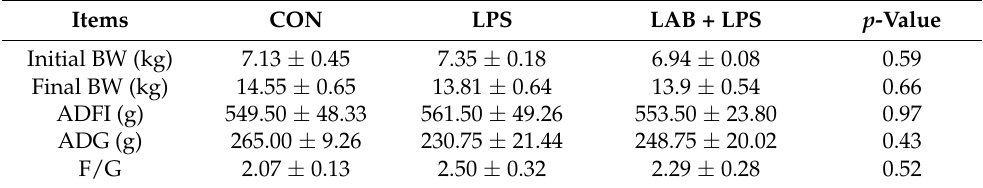
Table 2. The effects of Lactobacillus delbrueckii (LAB) supplementation on the growth performance of weaned